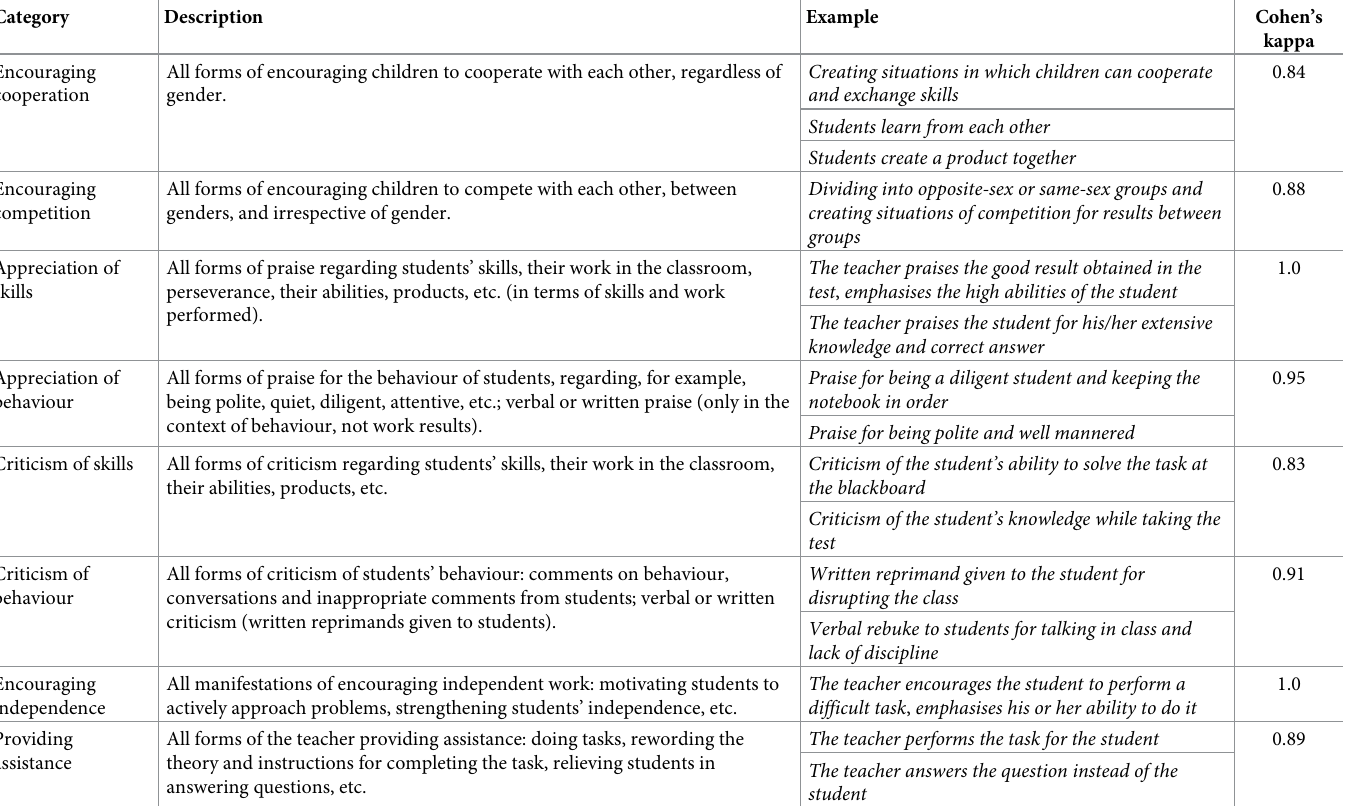
Table 2. Code categories of teachers’ behaviour and interrater